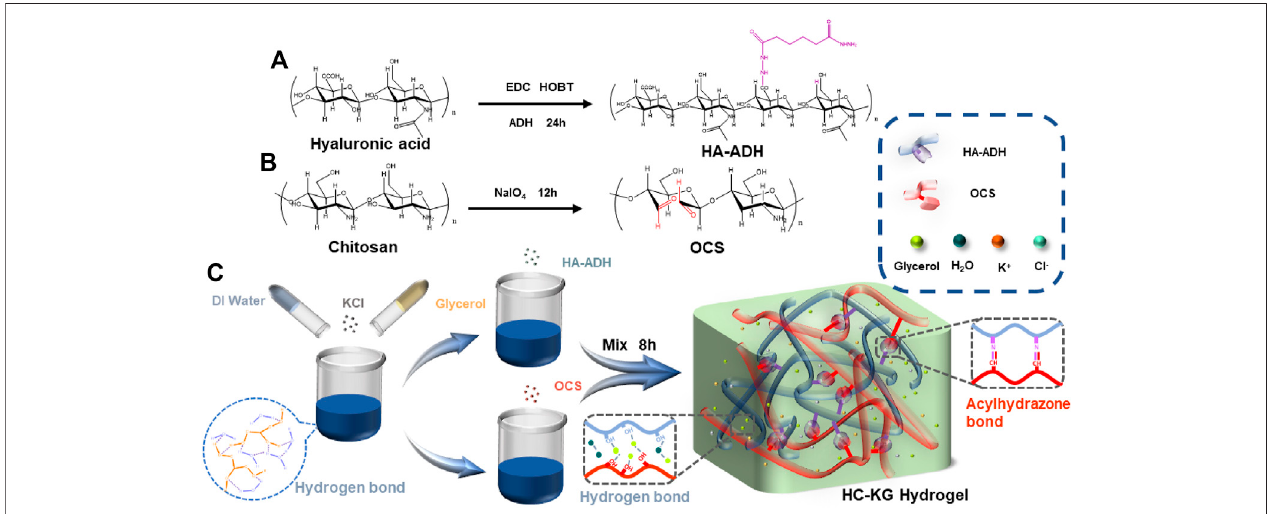
FIGURE1| Strategiesforthefabricationofthestretchable,self-healing,conductive,andanti-freezingHC-KGhydrogel.Thesynthesisrouteof (A) HA-ADHand (B) OCS (C) of the preparation steps and the network structure of the HC-KG hydrogel.